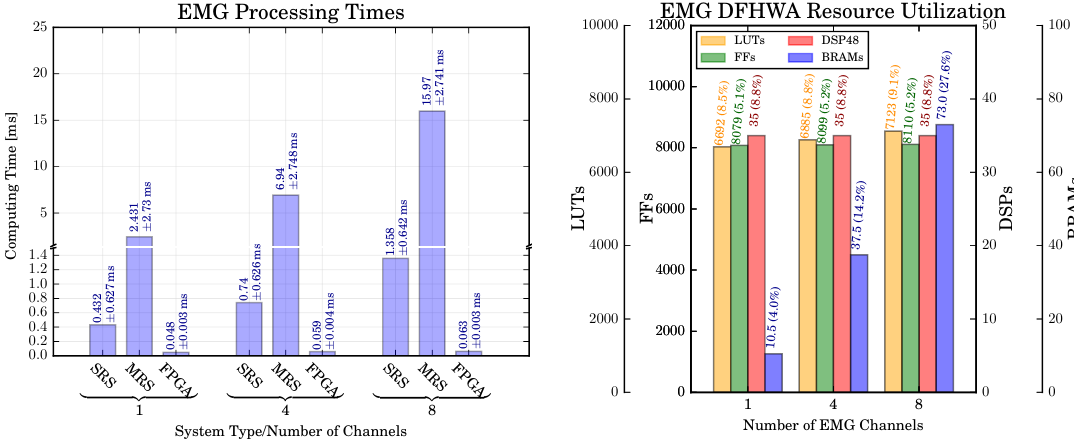
Figure 7. Left: Computation time for different computing setups for the detection of the movements based on the EMG. Right: Resource utilization of the Dataflow Hardware Accelerator (DFHWA) for different numbers of EMG channels. The percentage values refer to the amount of resources provided by the Zynq ZC7030 (see Section 3.1) (independently utilized 18kb Block Random Access Memorys (BRAMs) are reported as